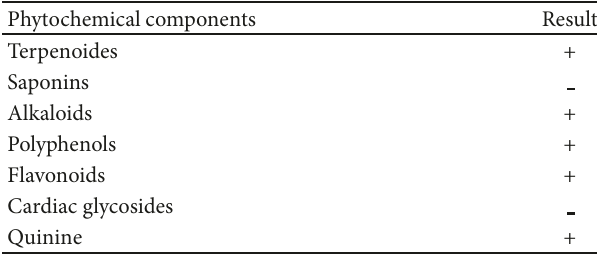
Table 1: Phytochemical screening of Sida rhombifolia aqueous- methanol extract of aerial